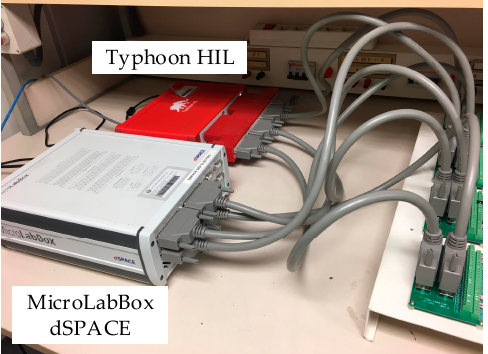
Figure 16. Experimental setup for real time test.